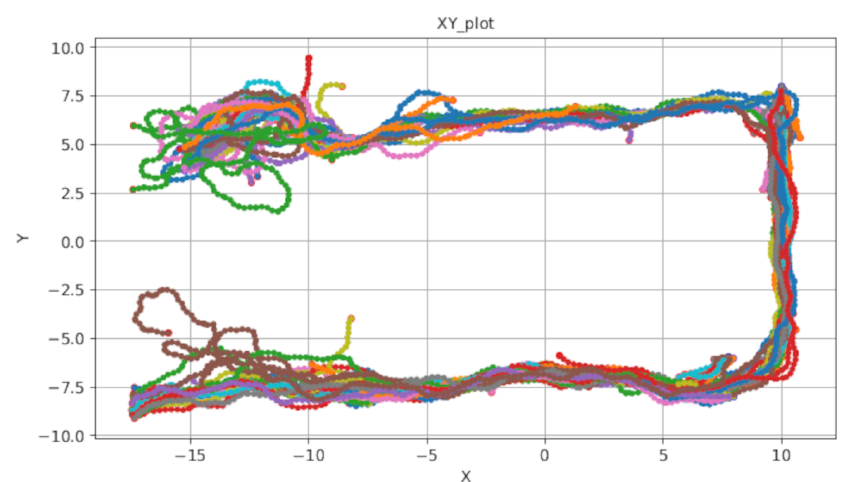
Figure 15. This diagram illustrates the navigation of UAV using untrained SCAN in the challenging environment (XY plane).